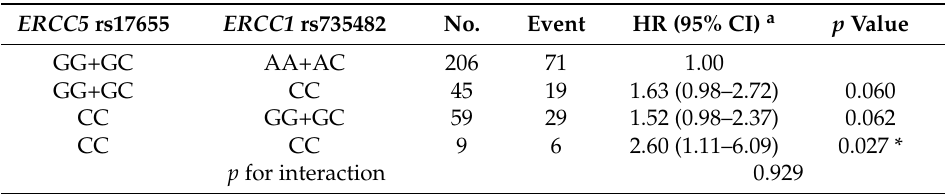
Figure 1. Kaplan–Meier survival curve for the combined ERCC5 rs17655 and ERCC1 rs735482 polymorphisms and disease-free survival in patients with oral squamous cell carcinoma treated with concurrent chemoradiotherapy. The figure illustrates a borderline significant difference in recurrence among the four groups (log-rank test p = 0.078). Table 4. Interaction between the ERCC5 rs17655 and ERCC1 rs735482 polymorphisms on the disease-free survival of patients with OSCC treated with CCRT.